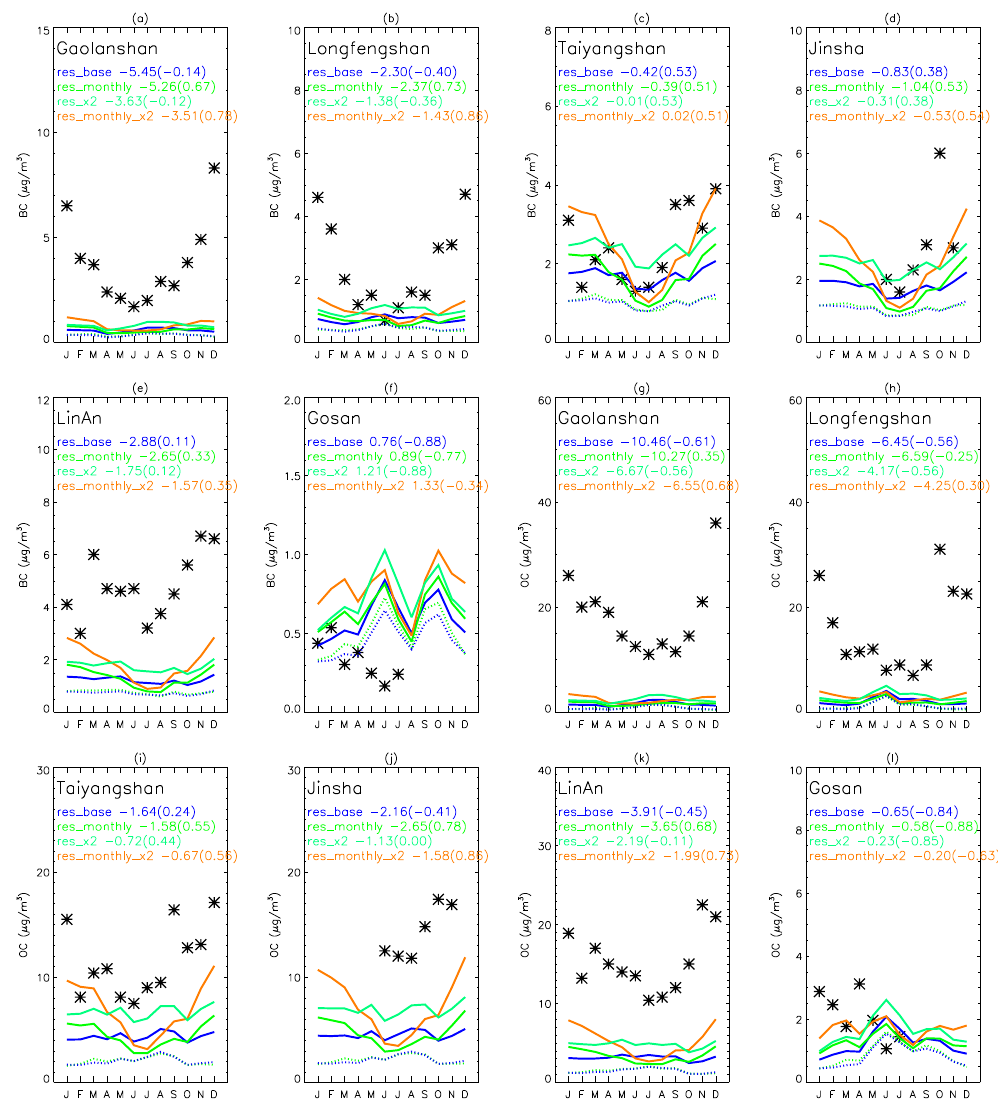
Figure 5. Observed (black stars) and simulated monthly mean BC (a–f) and OC (g–l) at East Asian locations. Normalised mean bias factor (NMBF) and correlation coefficient ( r ) are reported for each model simulation: NMBF (r) . Experiments where residential emissions have been removed are represented by the blue (res_base_off) and green (res_monthly_off) dotted